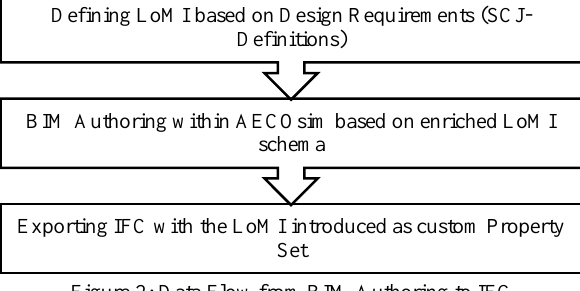
Figure 2: Data Flow from BIM Authoring to IFC